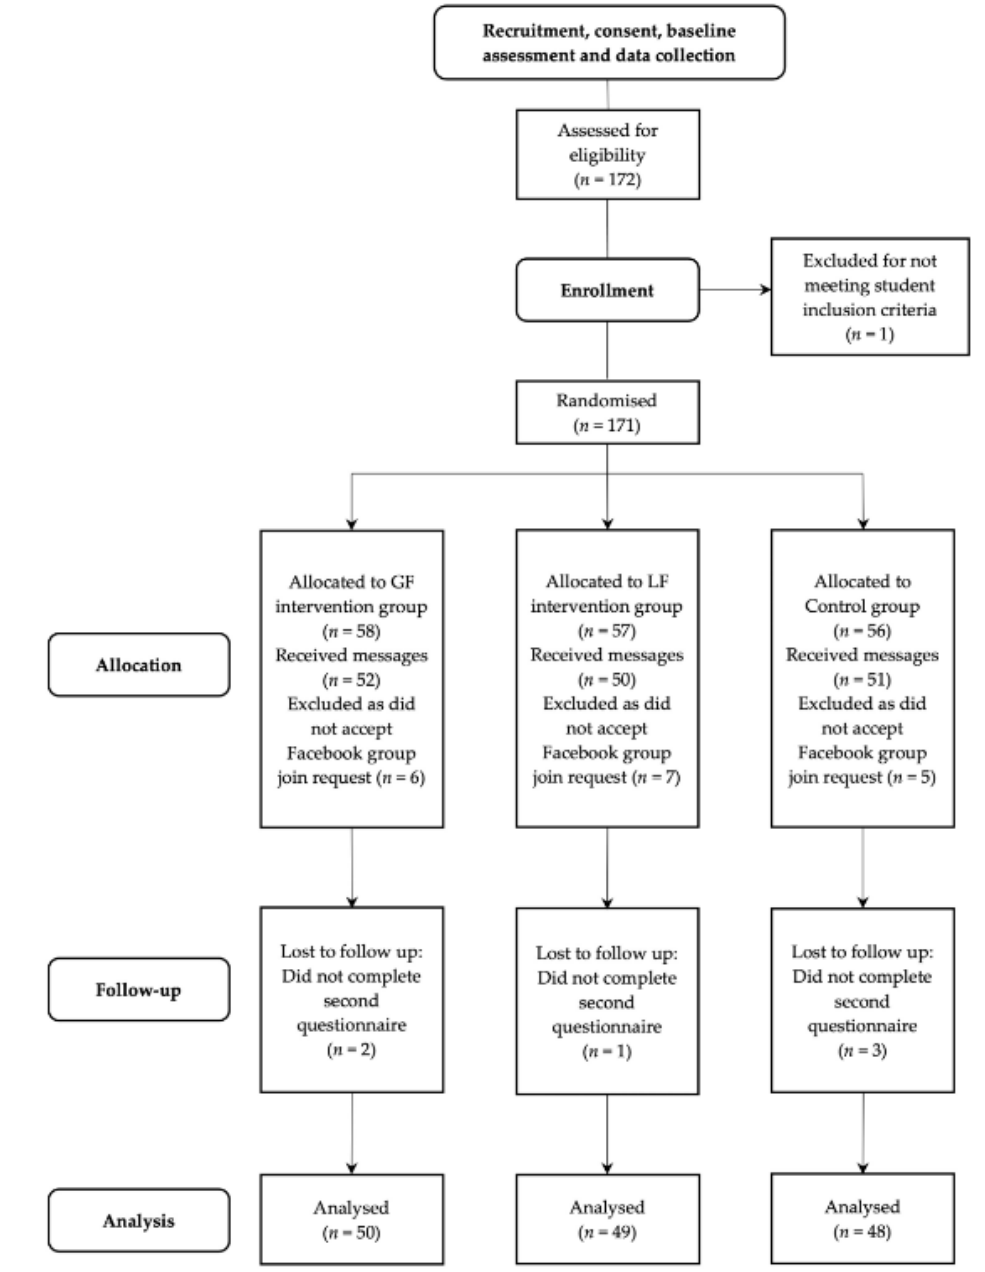
Figure 1. Consort study flow chart displaying the recruitment, intervention, and analysis process of the Facebook messaging intervention.